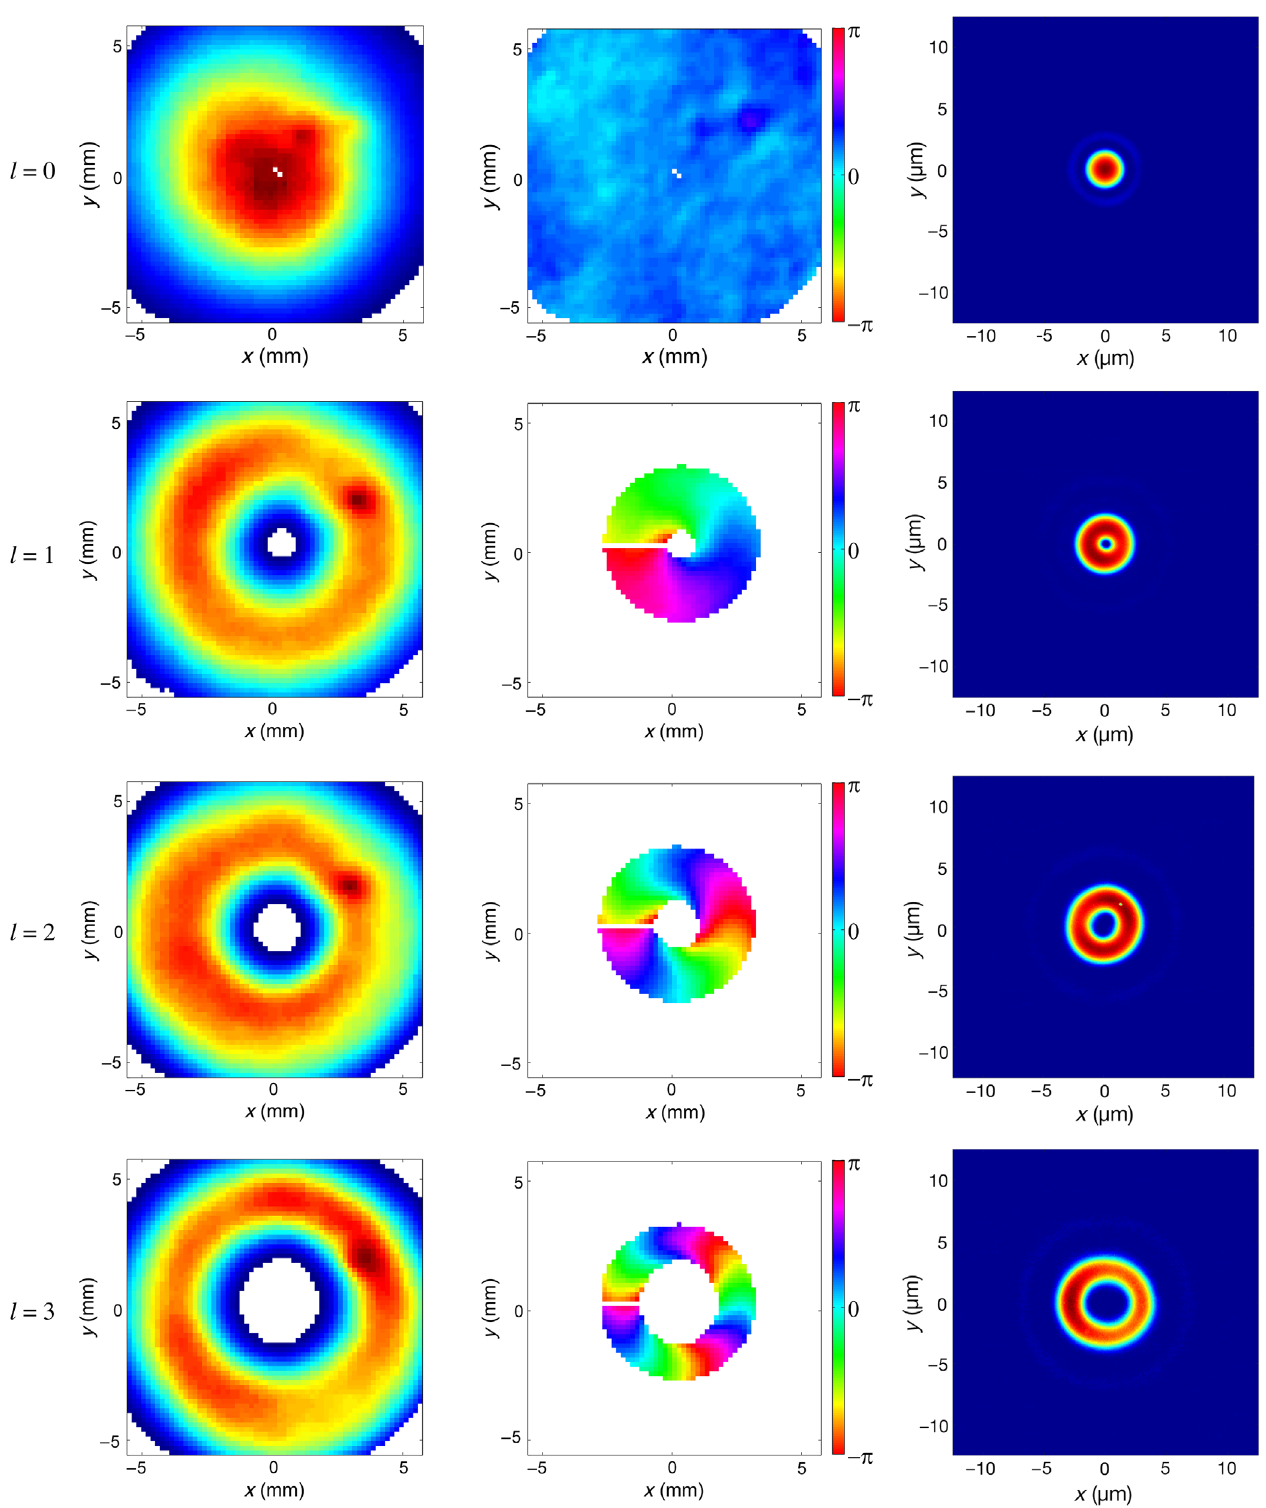
FIG. 7. Measured far-field intensity (left column) and phase (middle column), and the intensity distribution in the focal plane (right column) for ZPs with charges from 0 (top row) to 3 (bottom row). Because of the relatively long distance from the focus (800 mm), the phase gradients were below the detection threshold of the WFS far from the beam axis. We therefore had to limit the reconstruction of the phase to a circle with a radius of around 3 mm from the singularity point, as shown for l ¼ 1 , 2, and 3. All measurements were done in single-shot